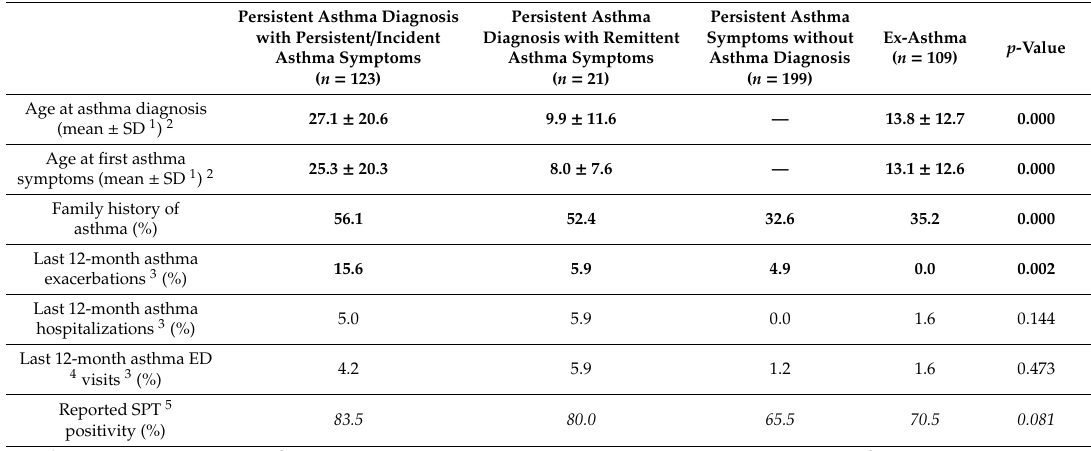
Table 5. Baseline asthma-related indicators by longitudinal asthma patterns.